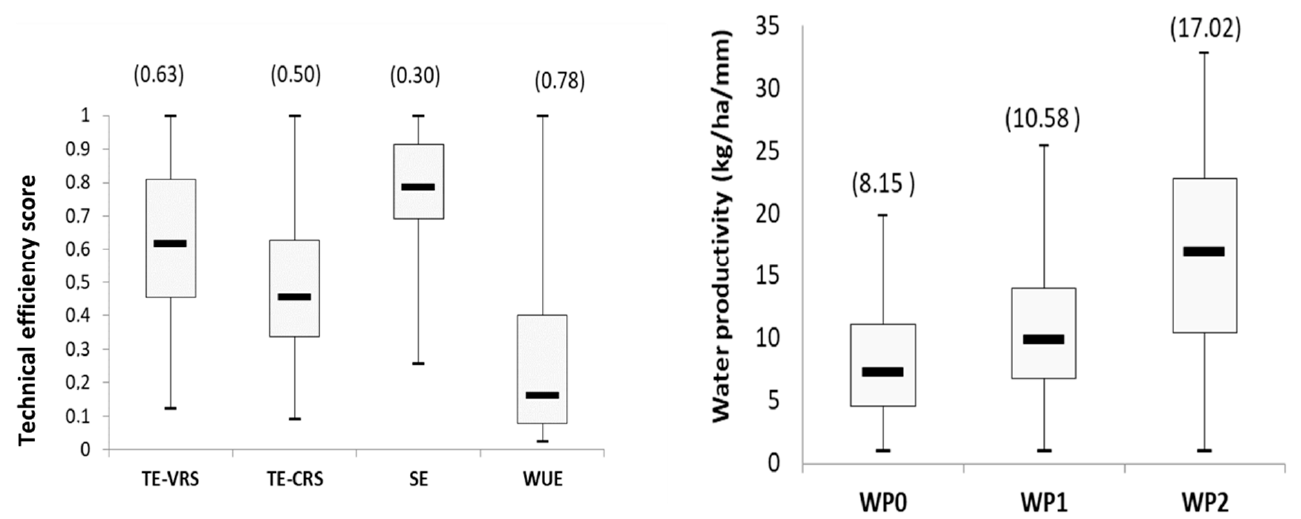
Figure 4. Box plot of TE, SE, WUE, WP0, WP1, and WP2. Table 5. Distribution of efficiency scores.